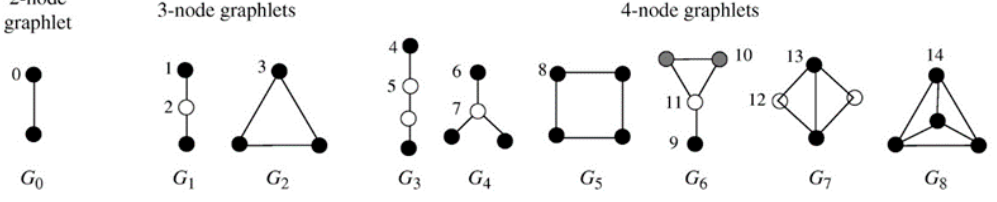
Figure 2. 2–4-node graphlets G0–G8 and their automorphism orbits0–orbits14